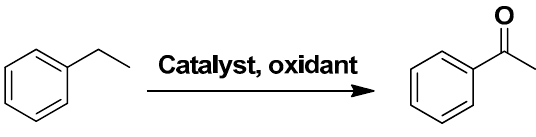
Scheme 2. General scheme of ethylbenzene